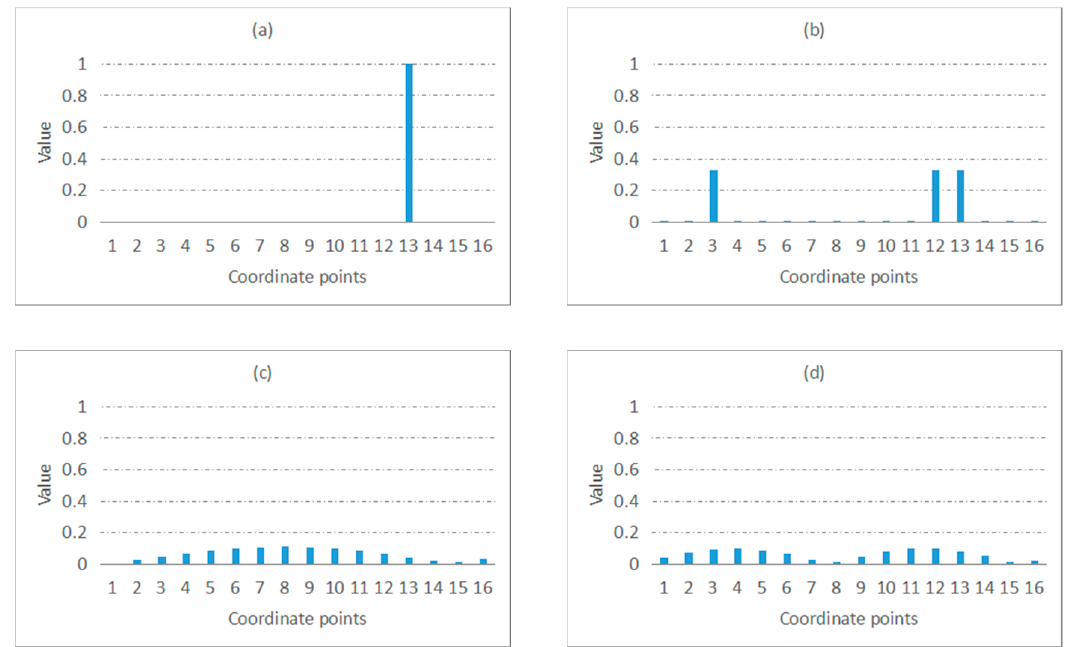
Figure 1. Four di ff erent functions of 16 values. ( a ) one point has value of one; ( b ) three points have values of 0.33; ( c ) sine wave function; ( d ) sine wave function with di ff erent